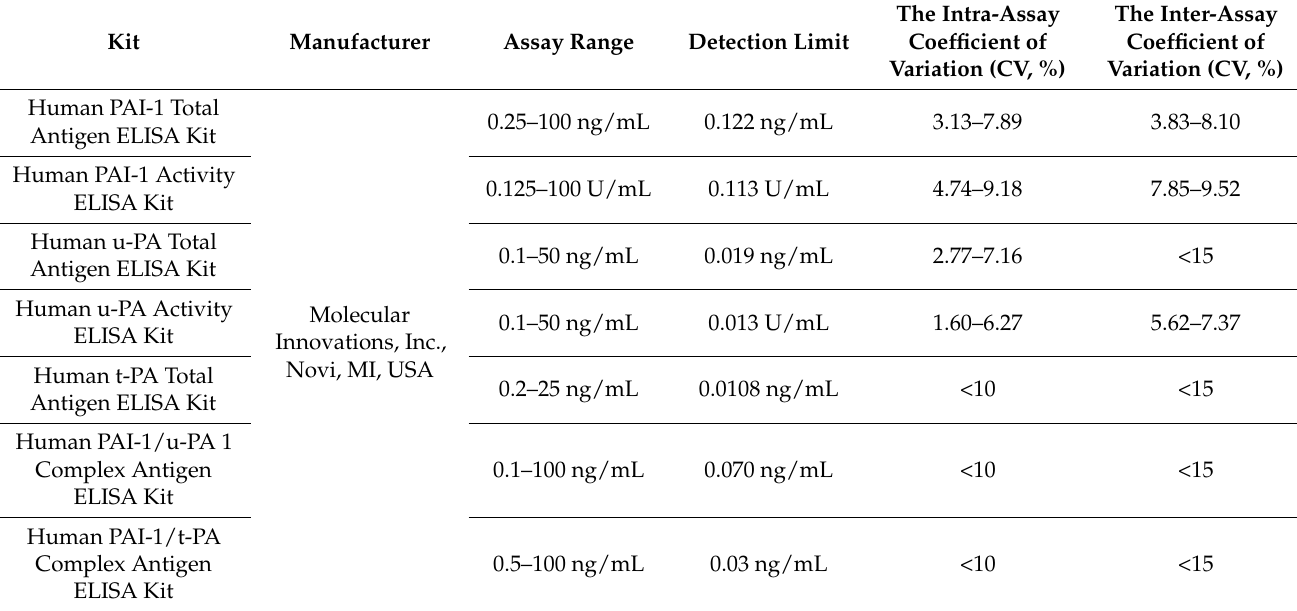
Table 2. The basic quality of enzyme-linked immunosorbent assay (ELISA) kits used in the present